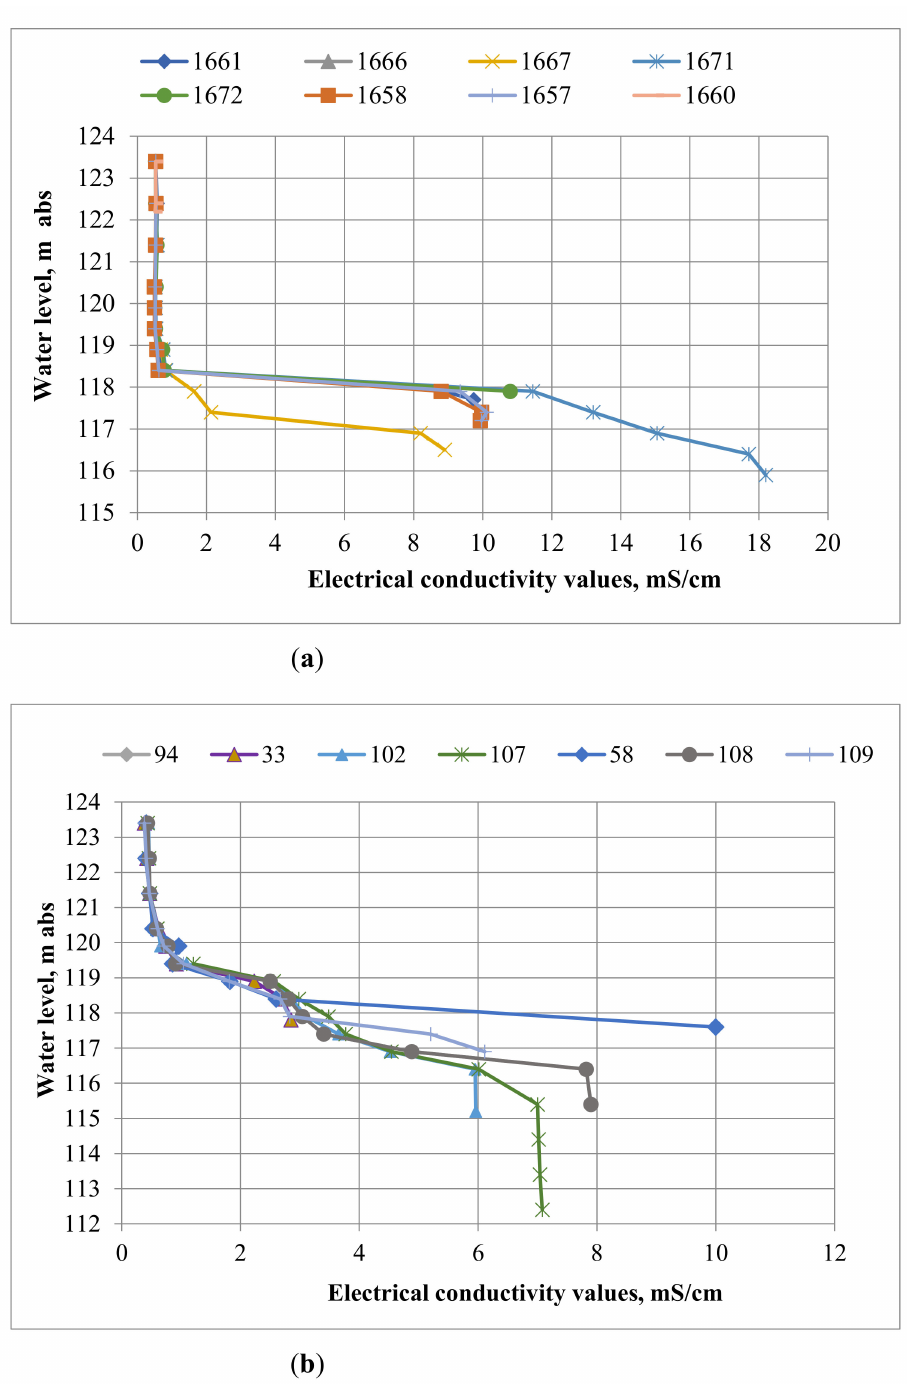
Figure 6. Vertical profiles of the distribution of the specific electrical conductivity of water on separate measured verticals in the Verkhne-Zyryansk reservoir during the summer ( a ) and winter low-water period ( b